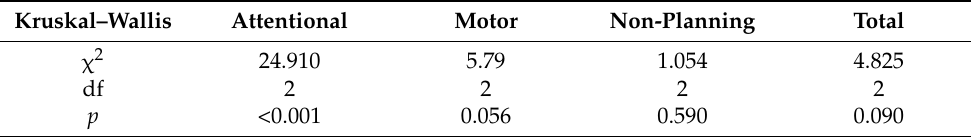
Table 2. Testing for significant group differences in the second-order factors attentional, motor, and non-planning impulsivity and the total score of the Barratt Impulsiveness Scale-11 using the Kruskal–Wallis Test. Abbreviations: df, degree of freedom; p , asymptotic significance; χ 2 ,